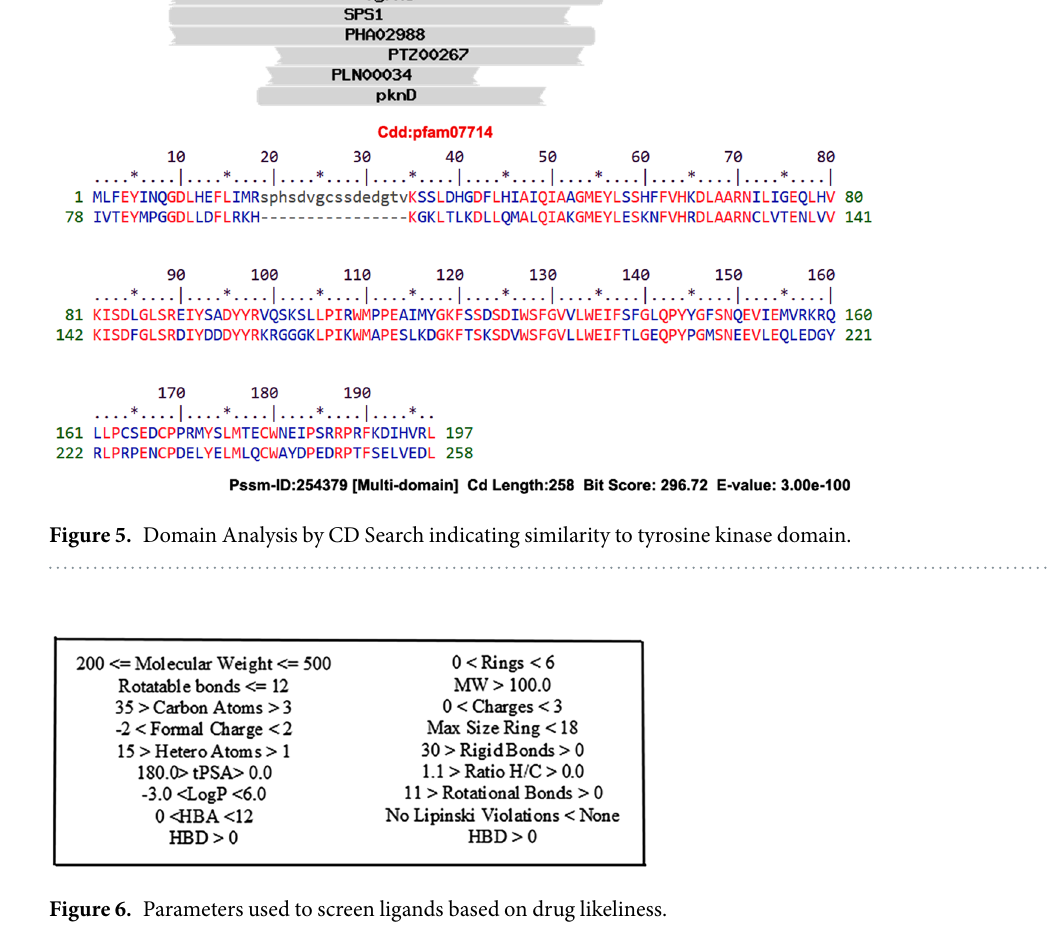
Figure 6. Parameters used to screen ligands based on drug